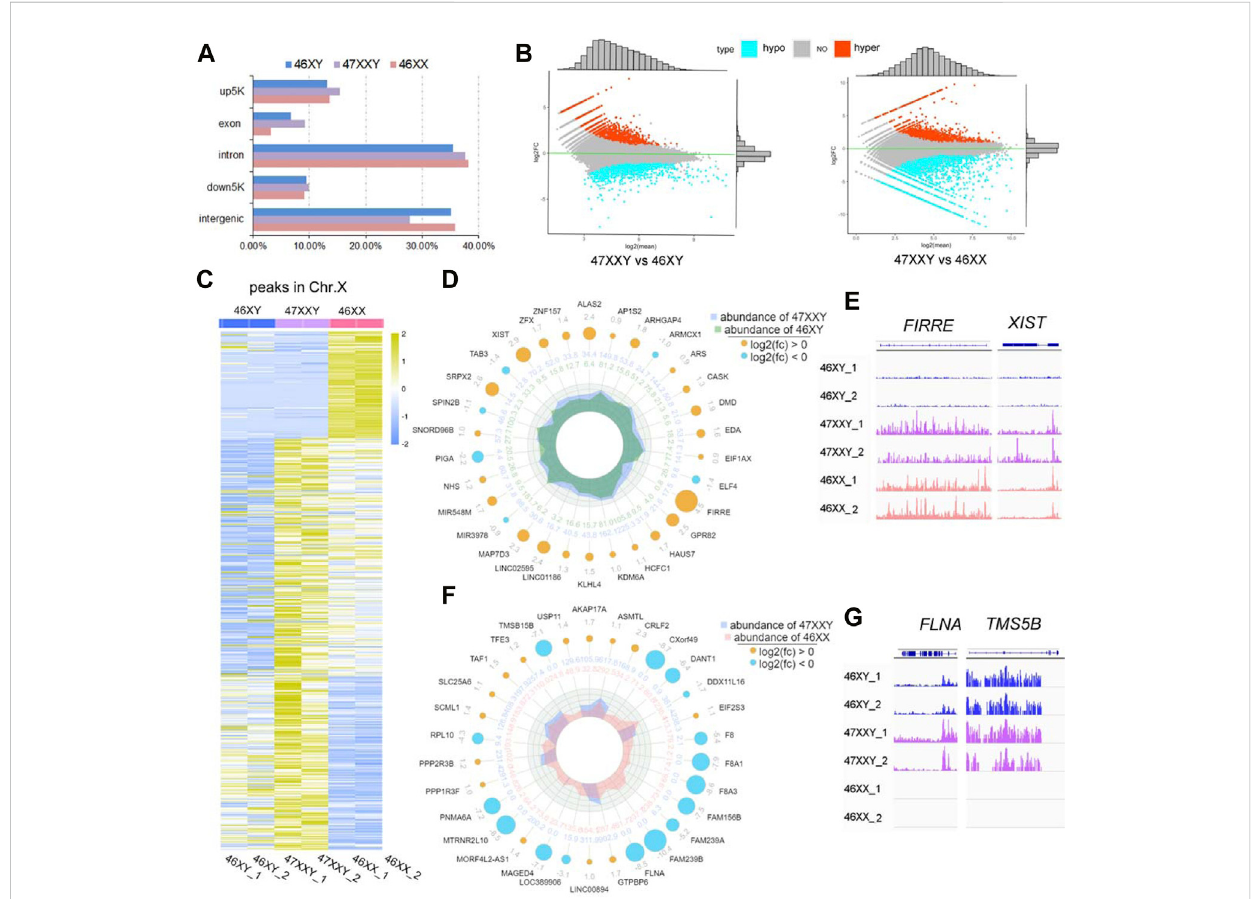
FIGURE 3 ATAC-seq of 6 amniotic samples (46XY, 47XXY and 46XX). (A) The bar plot of the proportion in different functional elements in 46XY, 47XXY and 46XX (up5K, exon, intron, down5K, and intergenic). (B) MAplot map of two combinations (47XXY vs. 46XY, 47XXY vs. 46XX). The X -axis represents log 2 meannormalized-countsand Y -axisrepresentslog 2 fold-change . (C) TheheatmapofthepeaksinChr.Xof46XY,47XXYand46XYgroups.Thebluetoyellow represent the methylation level from low to high. (D) Radar circus of the most signi fi cant hyper and hypo genes of Chr. X in 47XXY vs. 46XY. From outside to inside: gene name with log 2 (fold-change) . (E) IGV illustration map of hyper open abilities in Chr.X (46XY vs. 47XXY vs. 46XY). (F) Radar circus of the most signi fi cant hyper and hypo genes of Chr.X in 47XXY vs. 46XX. From outside to inside: gene name with log 2 (fold-change) . (G) IGV illustration map ofhypo open abilities in Chr.X (46XY vs. 47XXY vs. 46XY). FLNA and TMSB15B were the speci fi c peak genes in 46XY and 47XXY, and the empty signals mean that they are found in